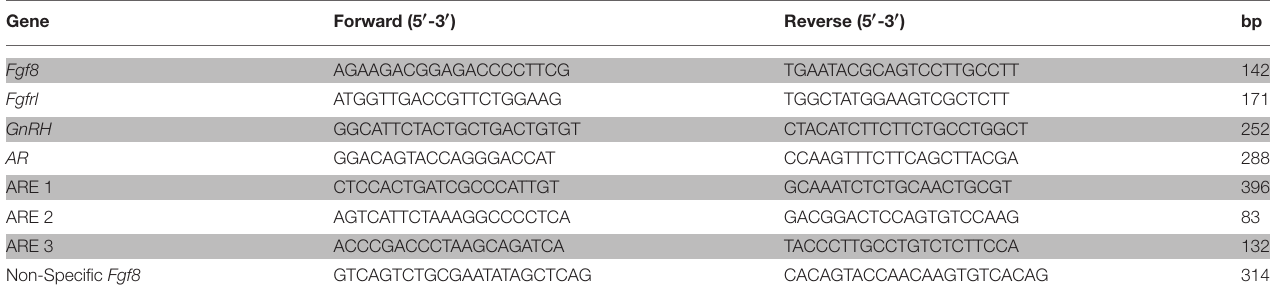
TABLE 1 | Primer sequences used for detecting Fgf8 , Fgfr 1 , GnRH and AR mRNA expression, and ARE containing DNA sequences within the Fgf8 promoter region.